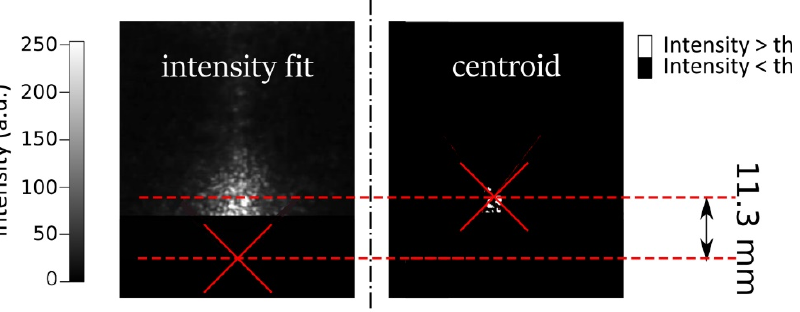
Figure 12. Example of the spot center measurement (red cross), if it falls out of the target, with fitting method and centroid method. The difference in the estimation is showed with dashed red lines.